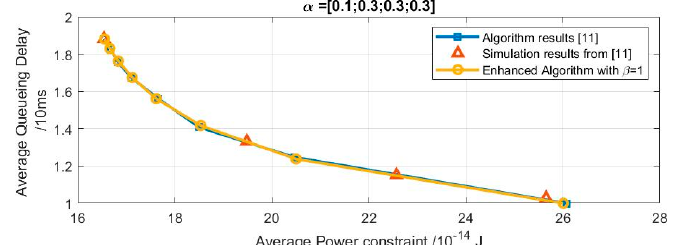
Figure 8. Perfect channel state tradeoff curve verification: results obtained from proposed model and results obtained from previous work.